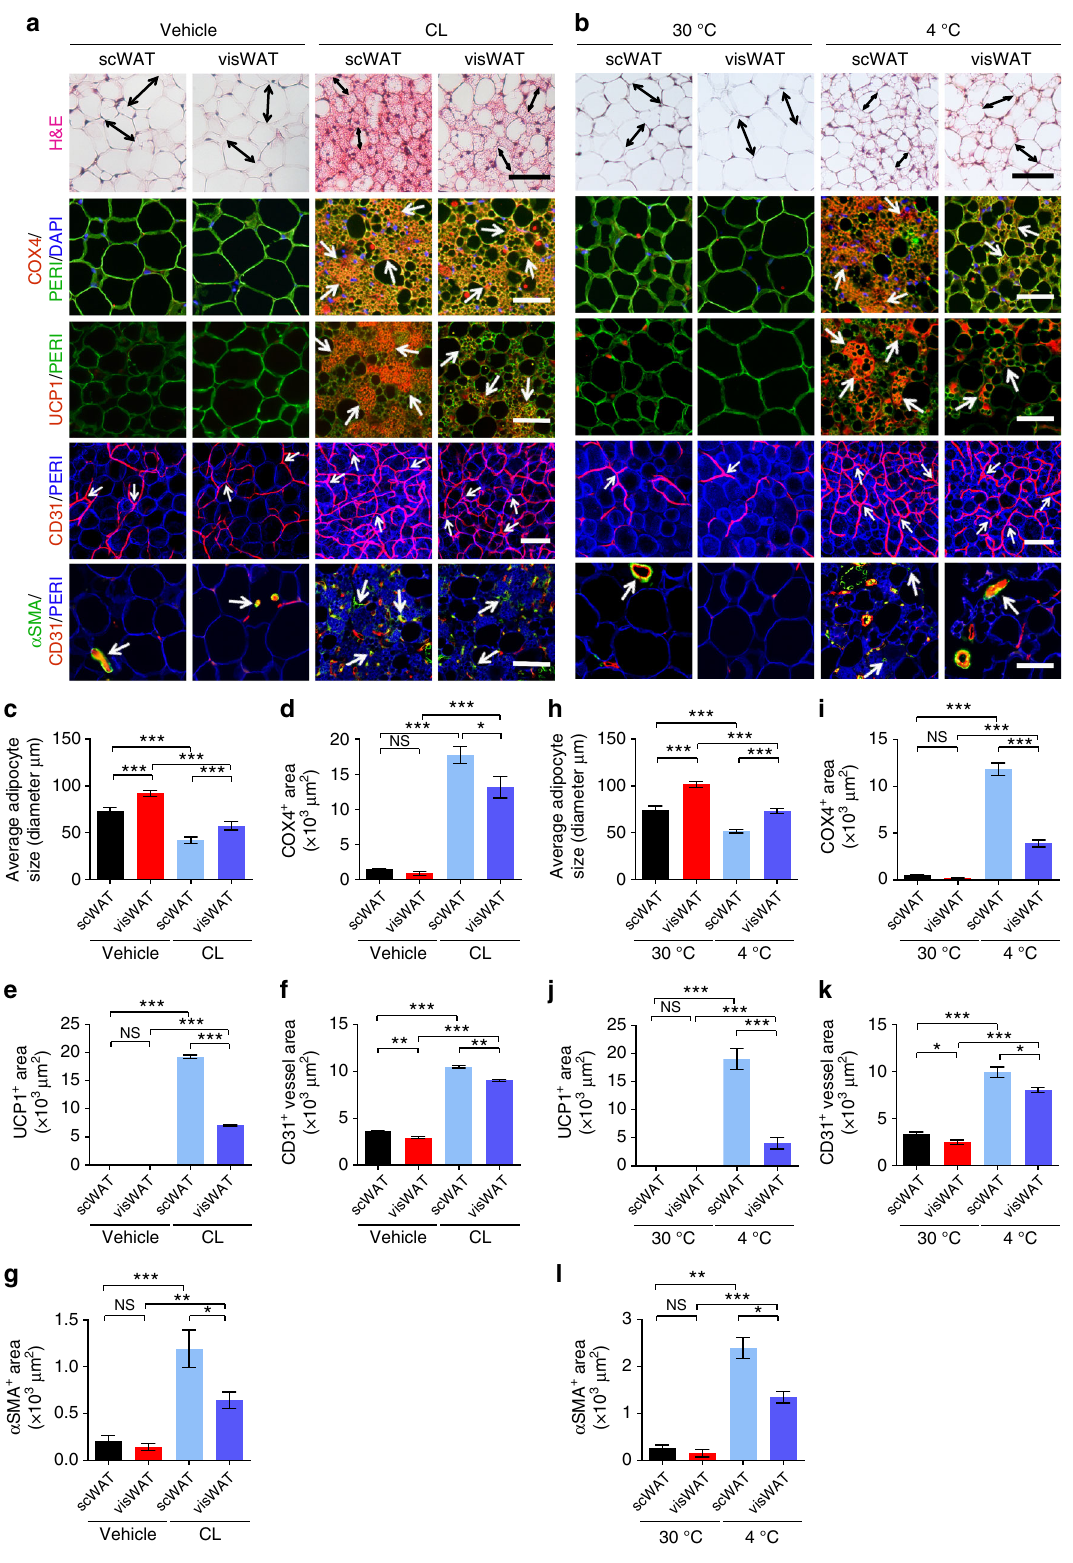
Fig. 1 CL and low temperature lead to WAT browning, angiogenesis, and an increased number of myo fi broblast-like cells. a , b Histological analysis of adipocyte morphology (H&E), adipocytes (PERI), mitochondria (COX4), uncoupling protein 1 (UCP1), blood vessels (CD31), and myo fi broblast-like cells ( α SMA) in a 5-day CL-316243-treated scWAT and visWAT compared to vehicle-treated control. b Two-week 4 °C-treated scWAT and visWAT compared to 30 °C control. Double-headed arrows mark adipocyte diameter. Arrows point to respective positive signals. c – l Quanti fi cations of adipocyte size and positive signals per fi eld of COX4, UCP1, CD31, and α SMA of CL-316243- and vehicle-, and 30 °C- and 4 °C- treated scWATs and visWATs ( > 30 adipocytes per fi eld; n = 10 random fi elds; n = 5 mice per group). PERI, perilipin; COX4, mitochondrial complex 4; UCP1, uncoupling protein 1. Scale bars, 100 μ m. NS, not signi fi cant. * P < 0.05, ** P < 0.01, and *** P < 0.001 by Student ’ s t -test. Data presented as mean ± s.e.m. NATURE COMMUNICATIONS | 8: 2079 | DOI: 10.1038/s41467-017-02158-z |